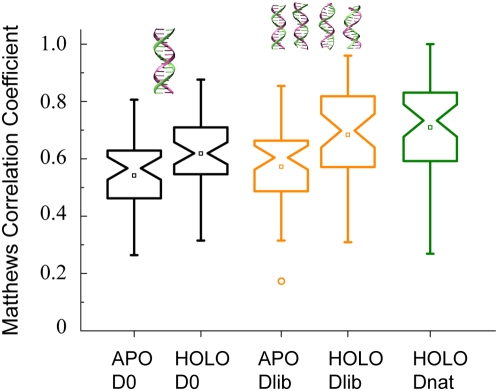
Improvement on DNA-binding site prediction using a DNA library
composed of poly dA·dT DNA in various conformations.D0 denotes the canonical B-DNA described above. Dlib denotes a library of
four 16 bp dA·dT B-DNA structures, which are shown in the
cartoon representations. Dnat denotes the 44 native-like poly
dA·dT DNA structures, each of which was built by keeping the
original sugar-phosphate backbone of the native DNA structure from the
holo-form complex and mutating the specific base pairs into the
dA·dT base pair using the base step geometry parameters of
the native DNA. The results shown are from the best of top five
clustering models.